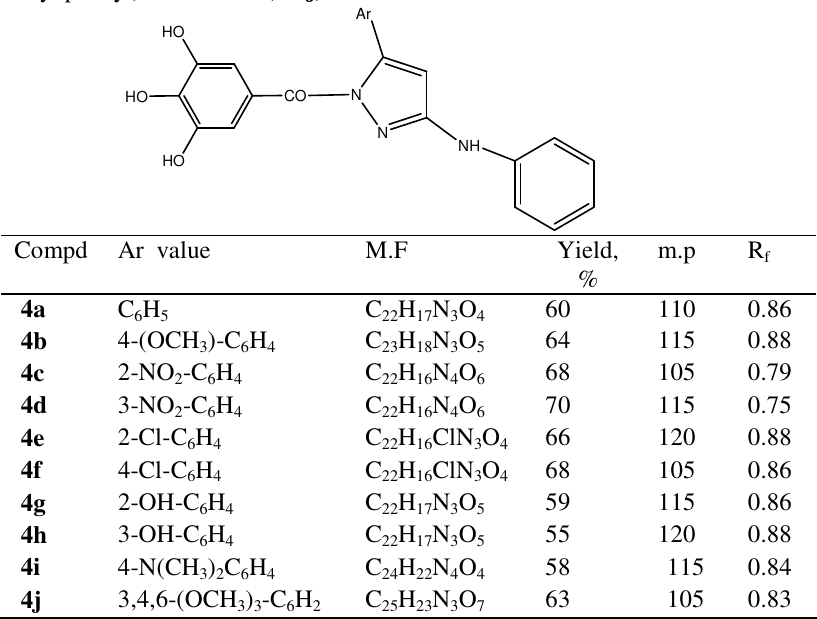
Table 1. Physical constants of [5-substituted-3-(phenylamino)-1 H -pyrazol-1yl] (3,4,5- trihydroxy phenyl)-methanone (4a-j)